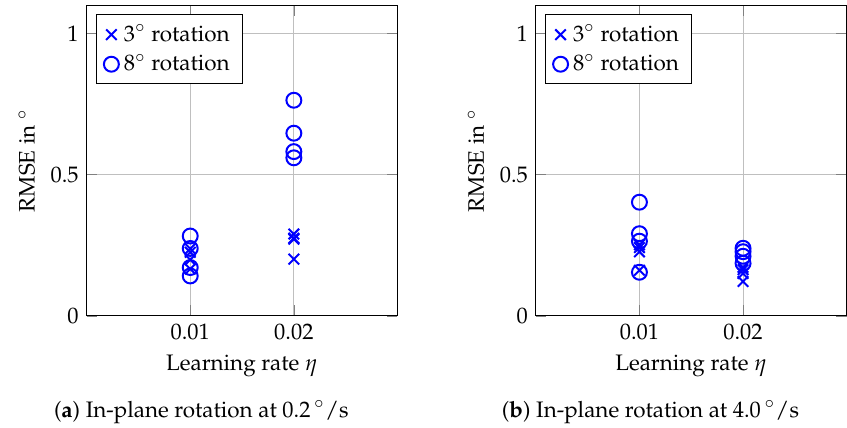
Figure 11. RMSEs for in-plane rotation of the flat-surface phantom.